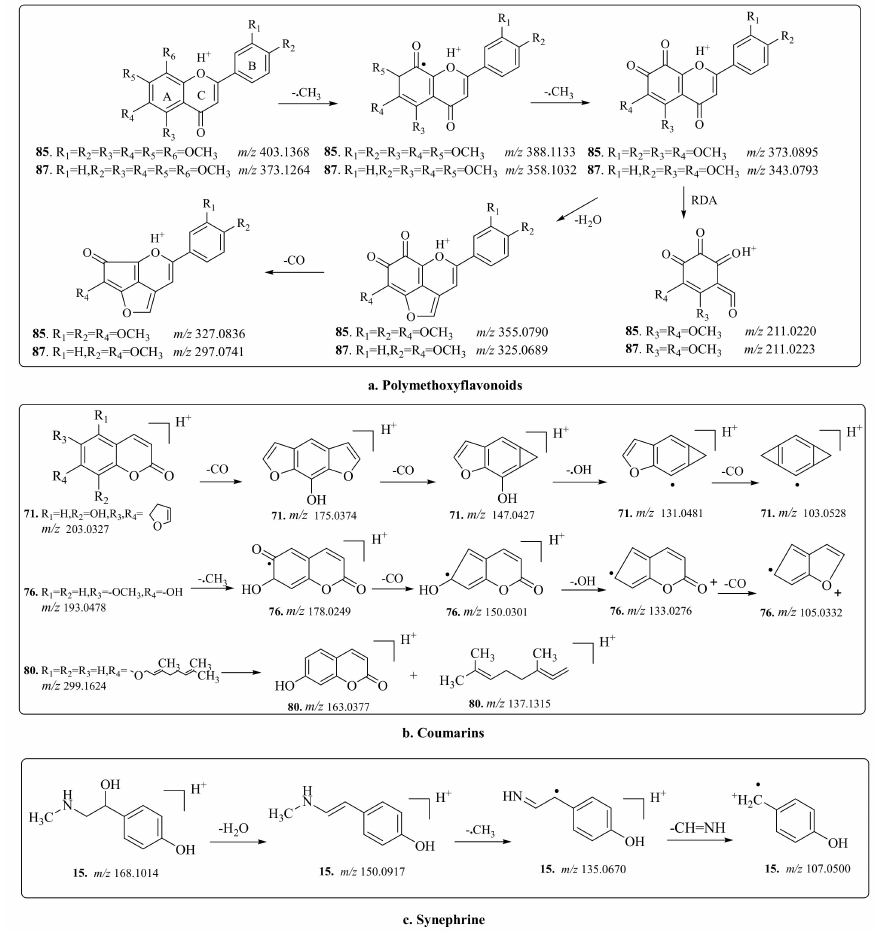
Figure 5. The proposed fragmentation pathways of six references. ( a ) Polymethoxyflavonoids; ( b ) Coumarins; ( c )